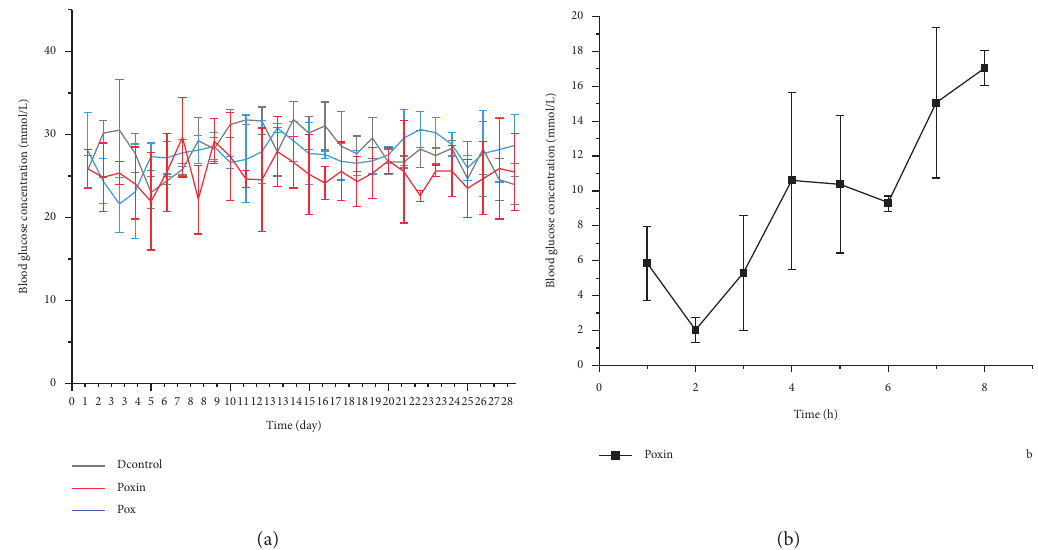
Figure 2: Mean ( ± SE) plasma glucose profiles of DControl, Pox, and Poxin groups for the 28 days of treatment period (a). Insulin injections were given in the morning and night, twice a day, with a dosage of 5 IU/kg/d. Their blood glucose could be maintained below 16.7mmol/L for about 7 hours after injection (b).